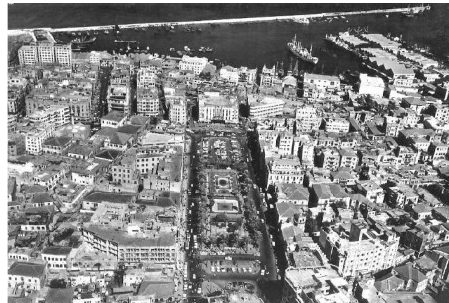
Figure 3. An aerial view of Beirut showing Martyrs’ Square (in the middle) surrounded by the urban tissue known as the Beirut downtown in 1958 (photo of a postcard from Nidal Chouman’s collection available at Beirut Heritage group, archived in